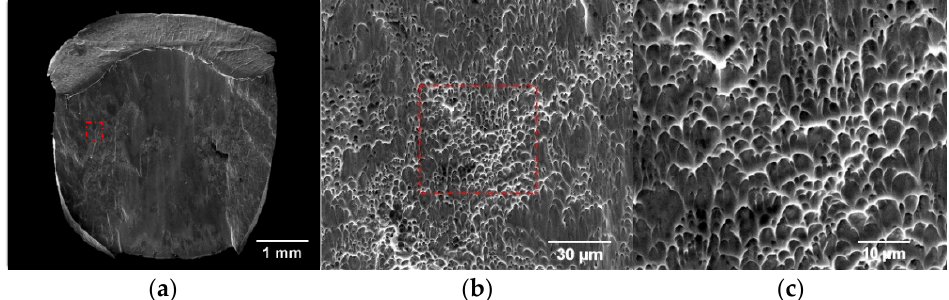
Figure 17. Fracture morphologies of specimen in the deposition direction. ( a ) Full view of the fracture. ( b ) 2000× magnification. ( c ) 5000× magnification.